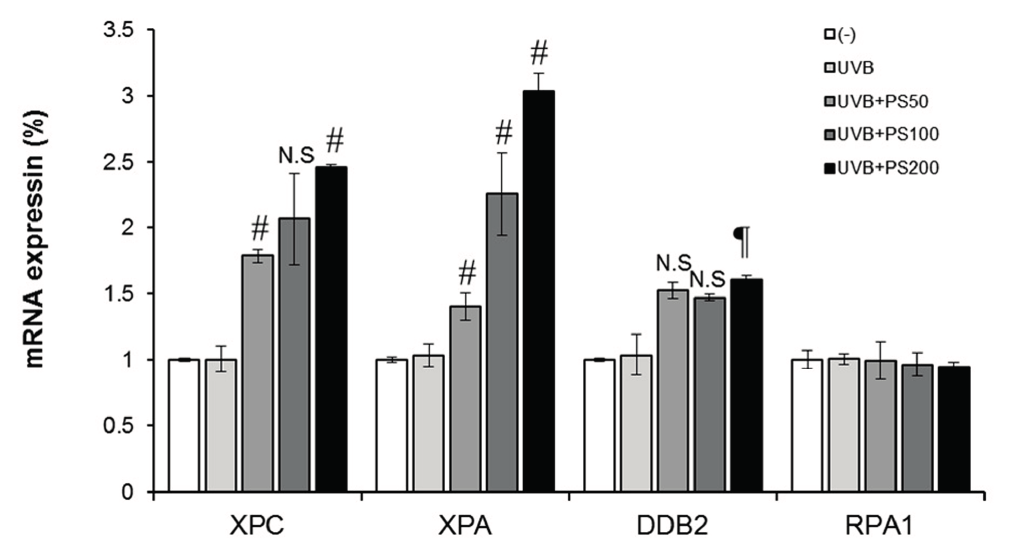
Figure 5. Phloretin 3',3-disulfonate stimulates the mRNA levels of NER genes in UVB-exposed HaCaT keratinocytes. HaCaT cells were exposed to UVB with and without the treatment of phloretin 3',3-disulfonate (50–200 µg/mL). Cells were harvested 3 h later and RNA was extracted. The mRNA levels of NER genes were determined by real-time PCR. NER genes mRNA expression levels are expressed as mean ± SD. Data are mean ± standard deviation of 3 independent experiments. ¶ p < 0.05 compared with the UVB-treated group, # p < 0.01 compared with the UVB treated group. ( N = 3); N.S: not significant; PS: Phloretin